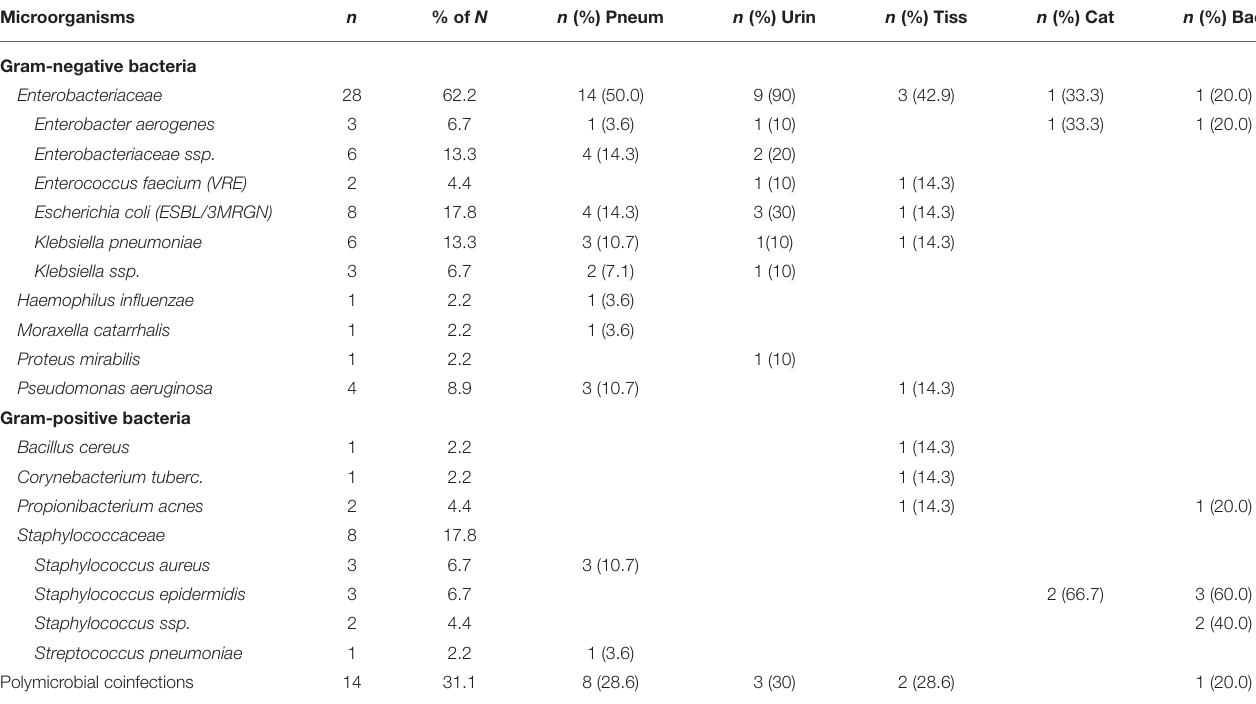
TABLE 3 | Spectrum of microorganisms in trauma patients with post-traumatic infections ( N = 45). Microorganisms n % of N